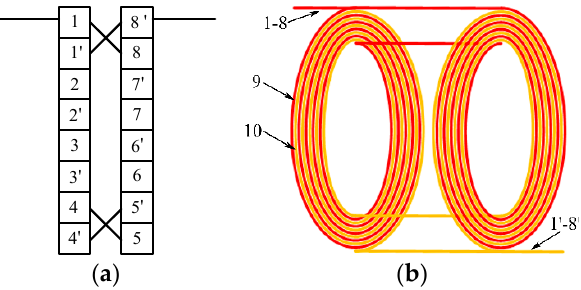
Figure 3. The method of coil winding: ( a ) Method of connecting wire; ( b ) Winding structure.